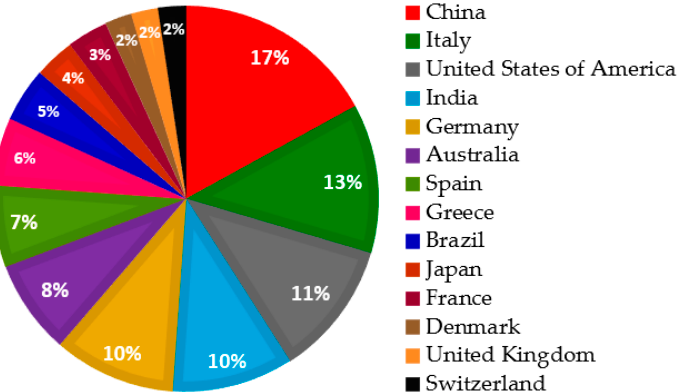
Figure 4. Scientific articles published by researchers from different countries (by 18 June 2021). Funding sources that are used to support those studies have been listed in Table 5, whereby could give some insight about which region(s) of the world is leading the pioneering role in the relevant research field. Table 5. Previous studies that received financial support for their research.